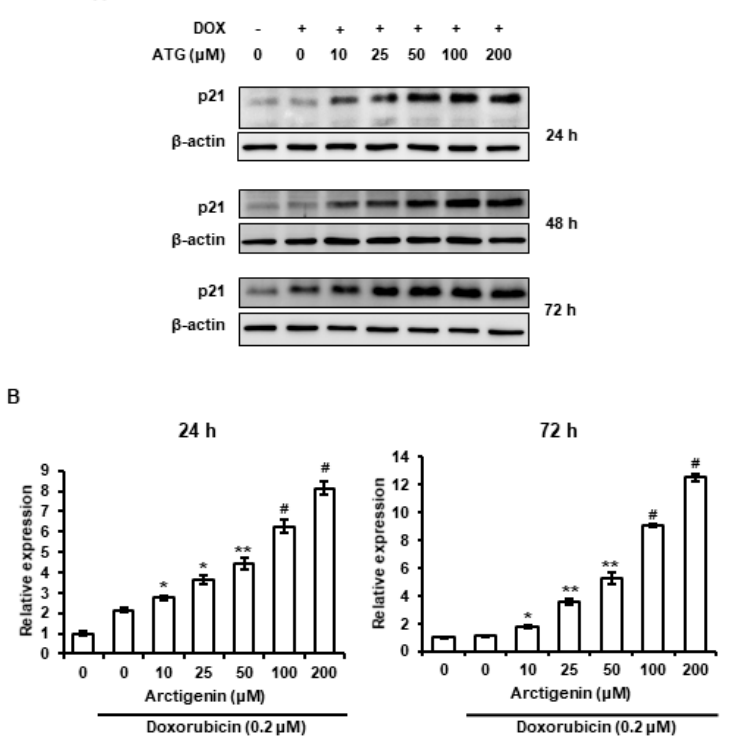
Figure 6. Effects of ATG/DOX co-treatment on p21 expression in MDA-MB-231 cells. ( A ) Cells were attached for 24 h and then co-treated with 0.2 μ M DOX and various concentration of ATG (0–200 μ M) for 24, 48, or 72 h in DMEM medium supplemented with 2% FBS. The expression of p21 protein was increased by ATG/DOX co-treatment. Proteins in whole cell lysates were separated by 15% SDS-PAGE and transferred to PVDF membranes. –: 0.2 μ M DOX-untreated, +: 0.2 μ M DOX-treated ( B ) Cells were attached for 24 h and then co-treated with 0.2 μ M DOX and various concentration of ATG (0–200 μ M) for 24 and 72 h in DMEM supplemented with 2% FBS, respectively. p21 mRNA levels were enhanced by ATG/DOX co-treatment. Relative p21 mRNA expressions were determined in triplicate and normalized versus GAPDH. *, **, # and ## indicate p < 0.05, p < 0.01, p < 0.001, and p < 0.0001 vs. DOX treated